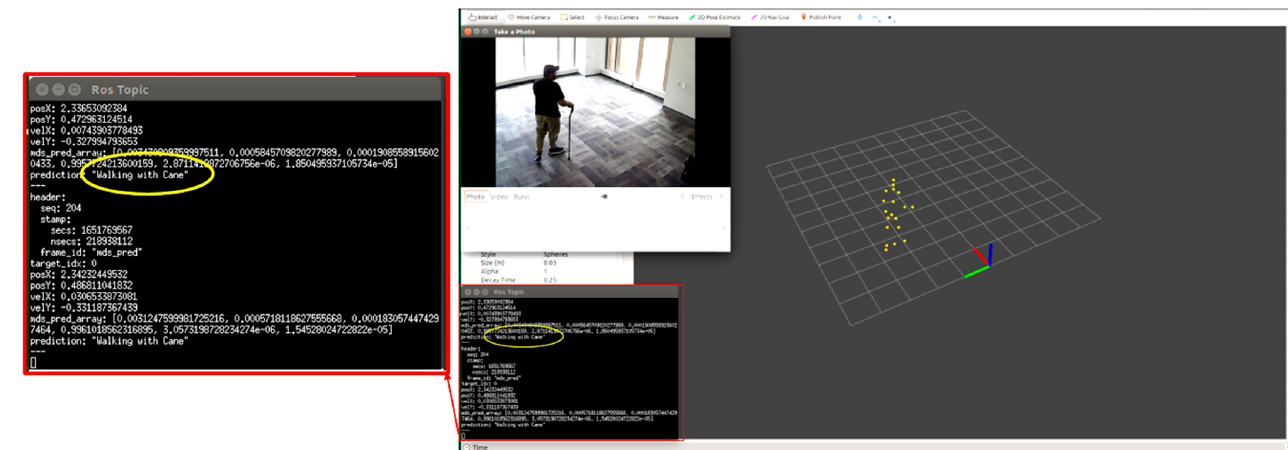
Figure 15. Subject walking with a cane.